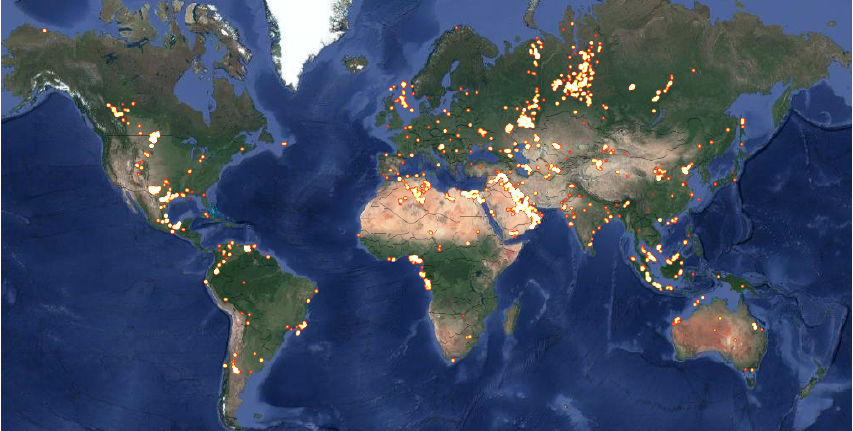
Figure 1. Satellite-detected natural gas flared in June 2020 over a 30-day span—obtain from SkyTruth